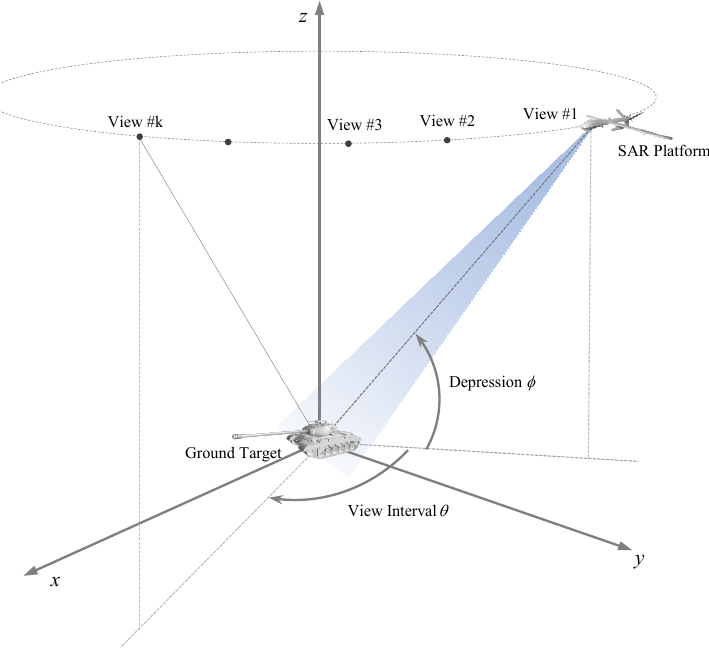
Figure 1. Multiview SAR ATR geometric model of a ground